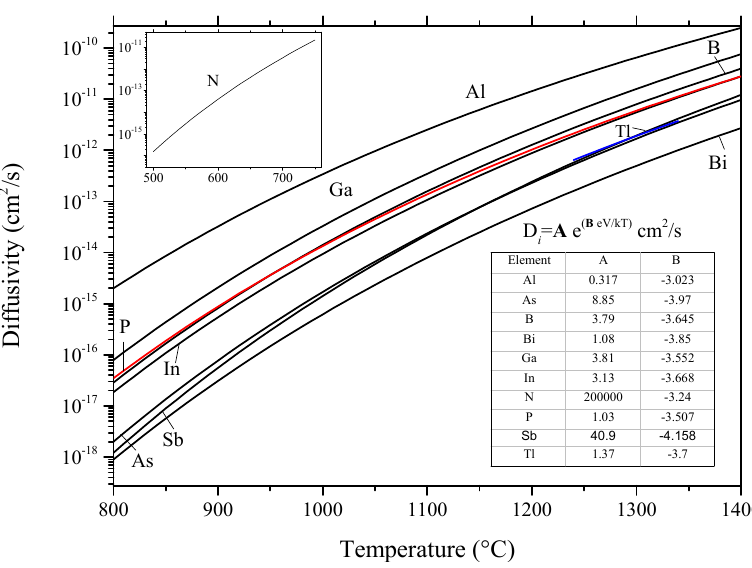
Figure 38. Summary of diffusivity of the studied elements in silicon. The parameters used in the